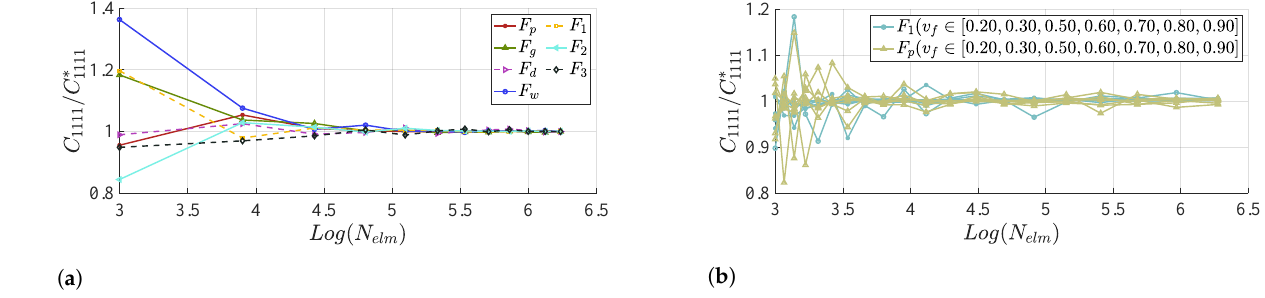
Figure 4. Convergence and mesh independence. ( a ) Density filter with linear interpolation in y -directions; ( b ) F P before applying density